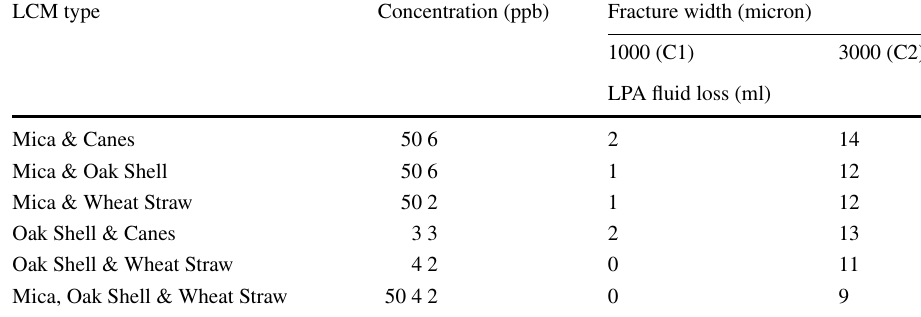
Table 12 LPA fluid loss results